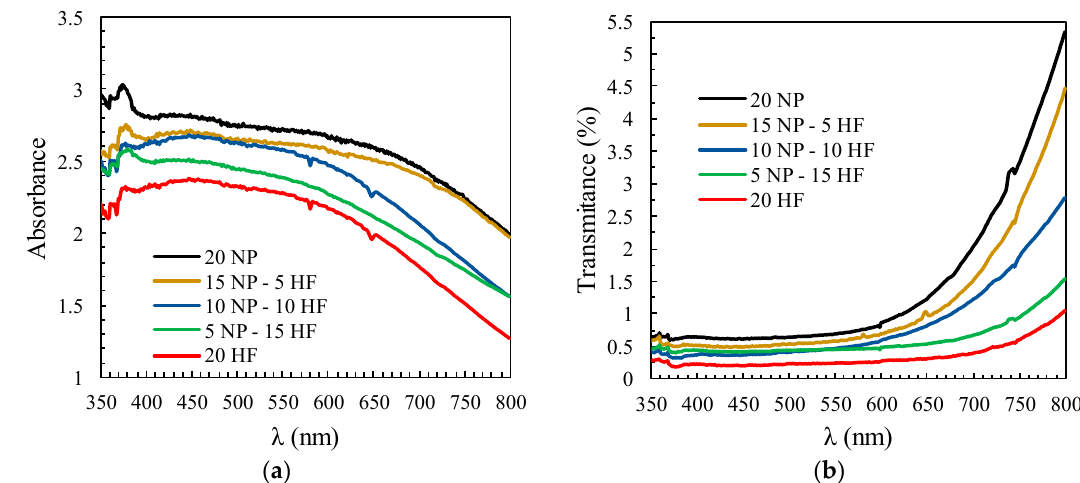
Figure 4. ( a ) Absorption and ( b ) transmittance spectra of TiO 2 NP and Zn-doped TiO 2 HF.